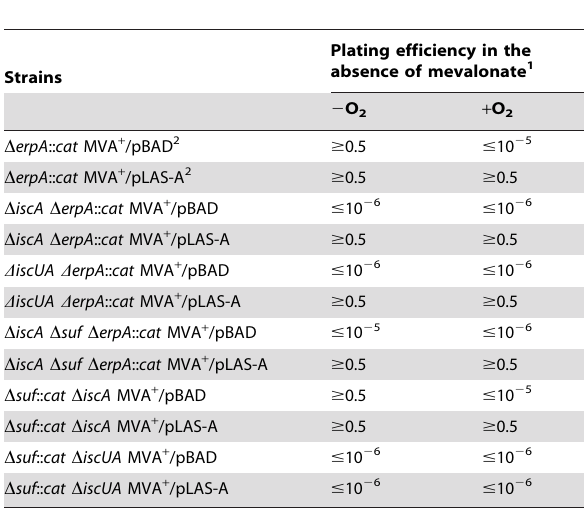
Table 5. Multicopy of sufA suppresses the phenotype of the iscA erpA double mutant via IscU or via the SUF system.